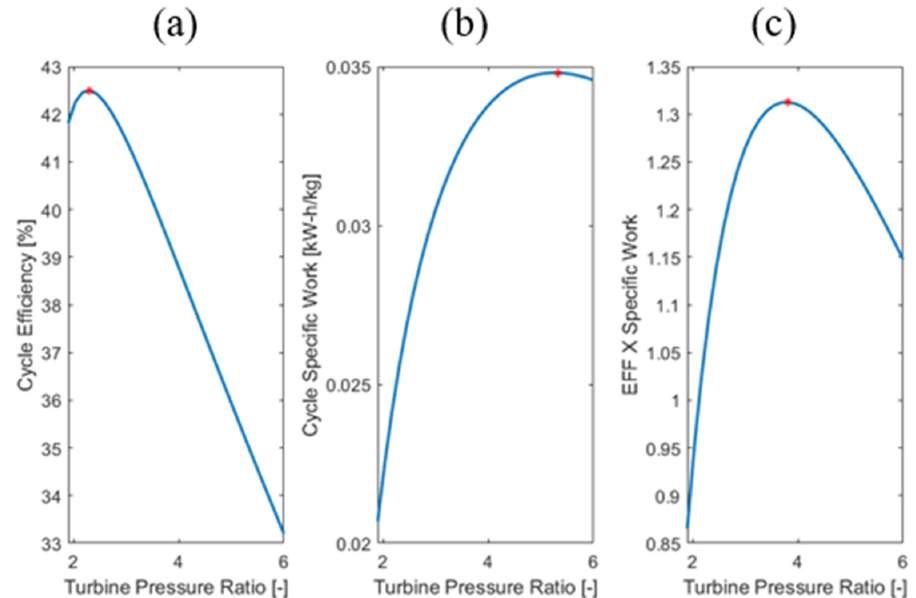
Figure 15. ( a ) Cycle Efficiency, ( b ) Cycle Specific Work, and ( c ) the mix mode along the turbine pressure ratio of open-air Brayton cycle.